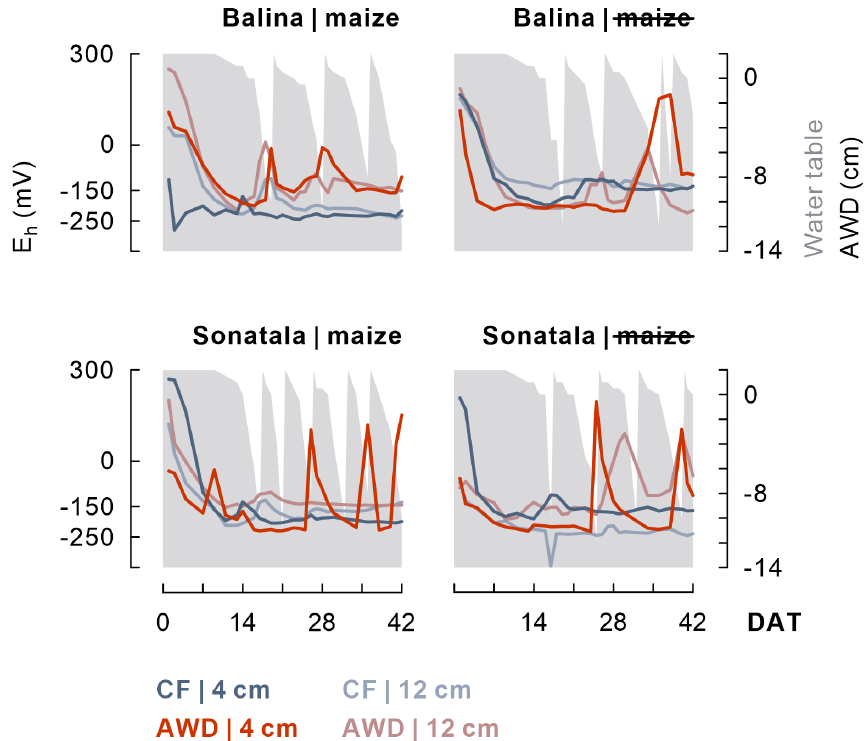
Figure 1. After a general initial drop, the soil redox potential ( E h ) (values per replicate at 4 and 12cm depth) depended to some extent on the irrigation treatment in both paddy soils (Balina and Sonatala). Water table fluctuations in the case of AWD are indicated in grey.